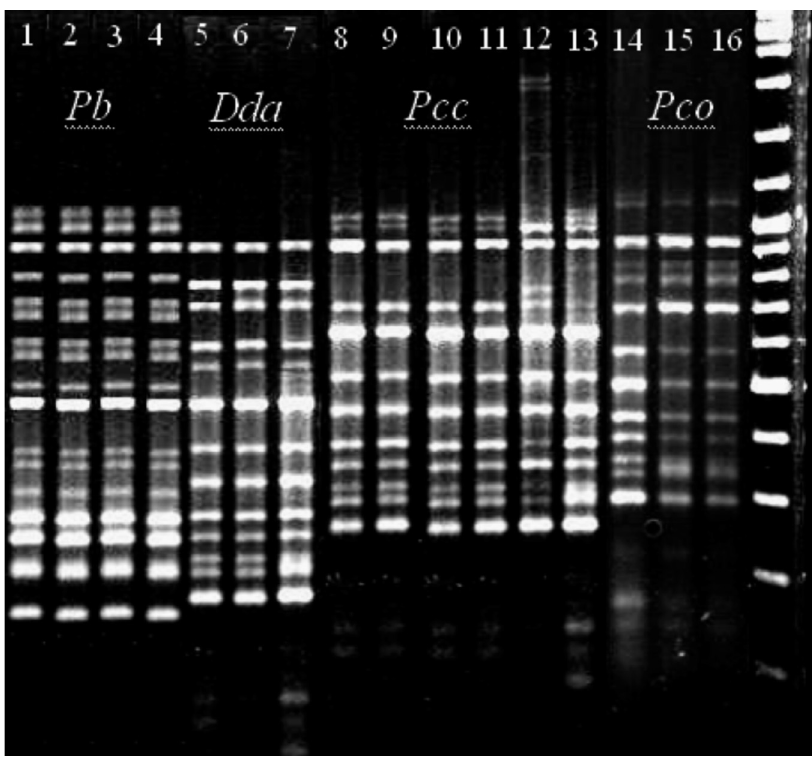
Figure 5. Agarose gel electrophoresis of PCR products obtained from representative strains of four distinct groups of Iranian soft rot bacteria with ERIC- primers. 1, S5; 2, S6; 3, S7; 4, S8 identified as Pectobacterium betavasculorum based on phenotypic characteristics. 5, EchSCRI 3739; 6, Pe3; 7, T4 identified as Dickeya dadantii based on phenotypic characteristics. 8, EccSCRI 193; 9, O2; 10, Cb2; 11, S3; 12, T1; 13, O1 identified as Pectobacterium carotovorum subsp. carotovorum based on phenotypic characteristics. 14, Po2; 15, T5; 16, Cb5 identified as Pectobacterium carotovorum subsp. odoriferum based on phenotypic characteristics. M, 1 Kb DNA molecular